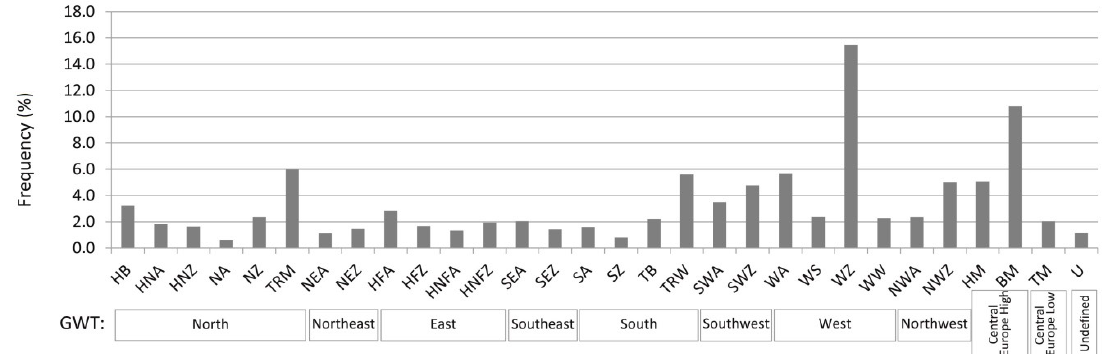
Figure 11. Frequency of Grosswetterlagen (GWL) circulation types in the years 1966–2015. Explanations of the GWL types: see Table 1.